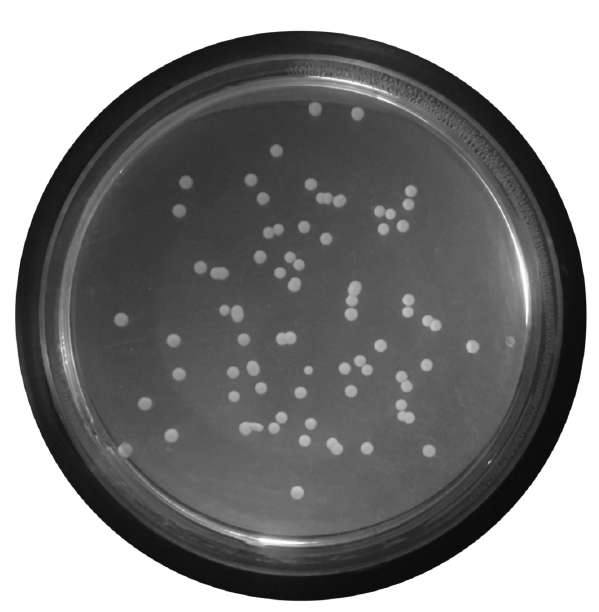
Figure 6. Median-filtered